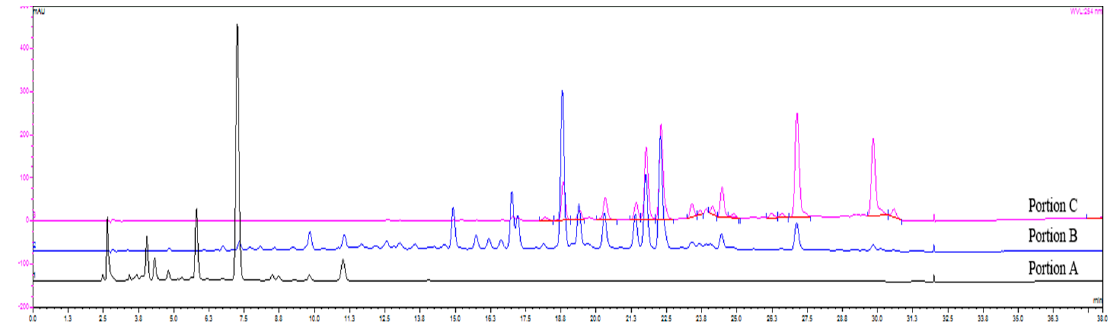
Figure 3. The HPLC fingerprints of three portions separated from GBE via D101 macroporous resin.